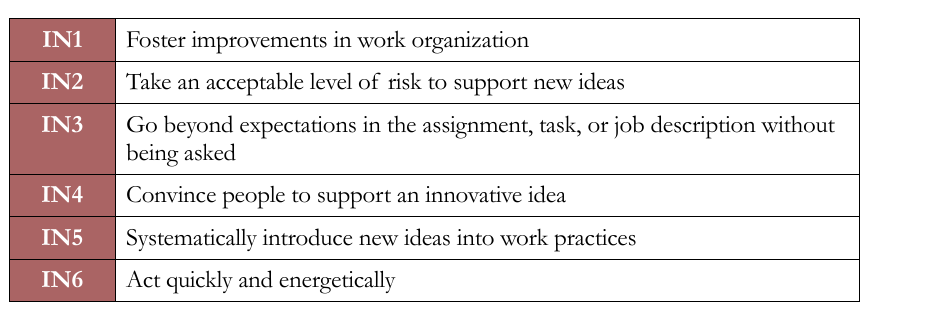
Table 5. Behavioral indicators in the FINCODA Initiative dimension